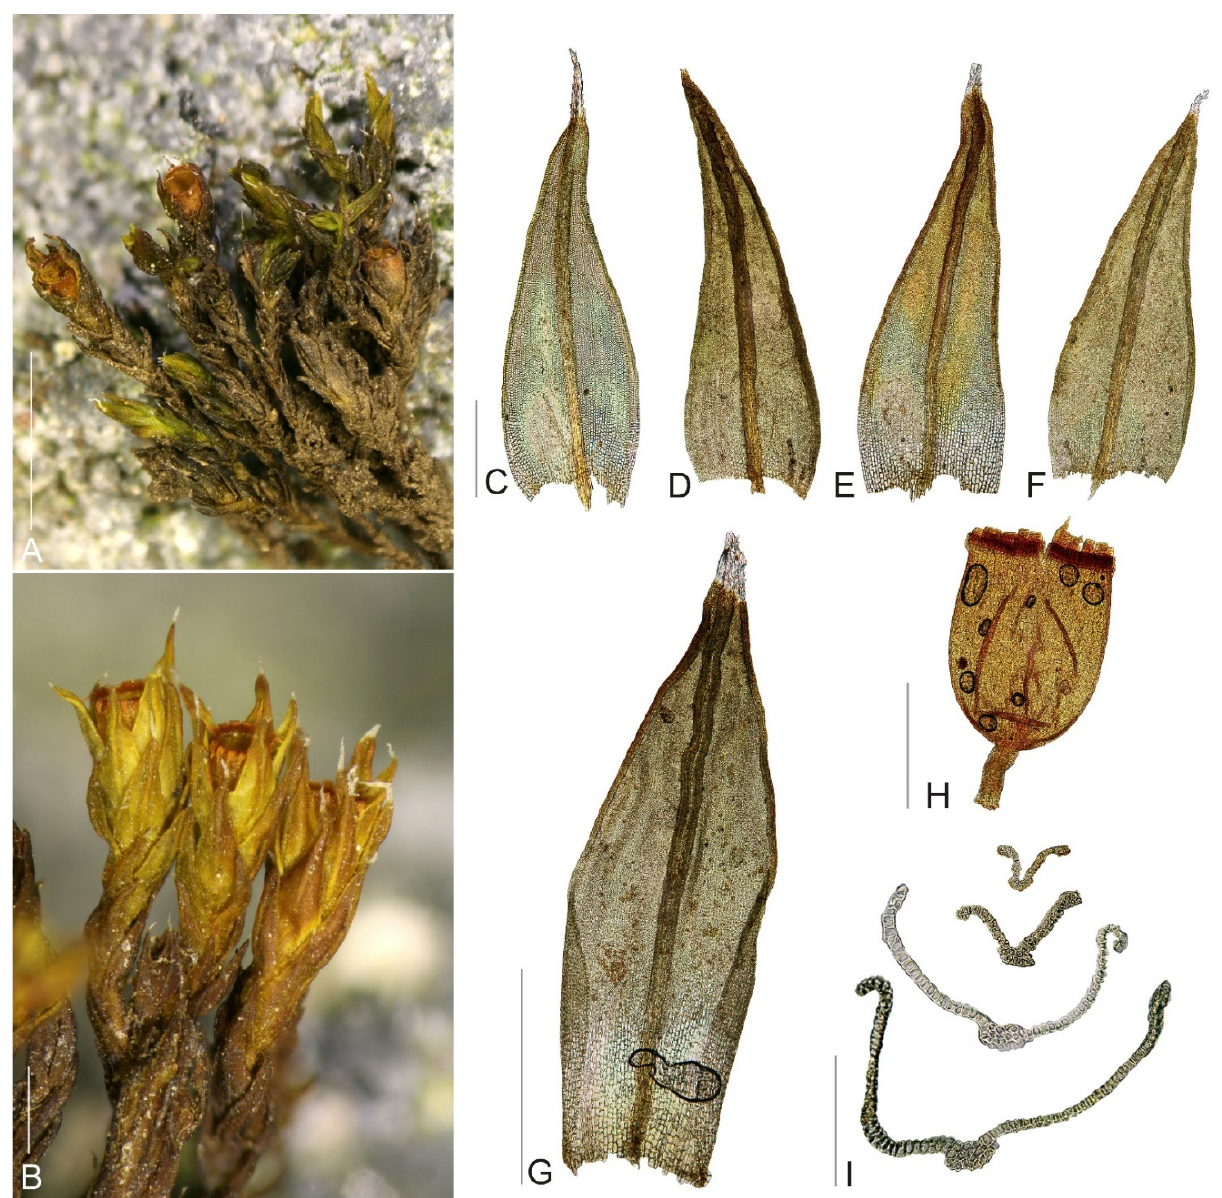
Figure 2. Macro and micro photographs of Schistidium marginale : ( A , B ) view on fertile plants; ( C – F ) leaves; ( G ) perichaetial leaf; ( H ) capsule; ( I ) leaf cross-sections (from the base of the leaf to the tip). Scale bars: A —1 cm, B —1 mm, C – F —0.5 mm, G —1 mm, H —0.5 µm, I —0.1 mm. All photos from specimen OSTR #7251, made by V. Plášek.